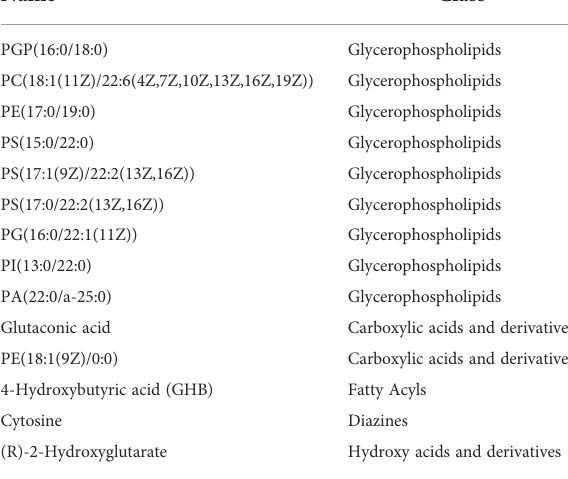
TABLE 2 The longitudinal trajectories of 14 signi fi cant metabolites in response to liraglutide overlapped with those of T2D at baseline.